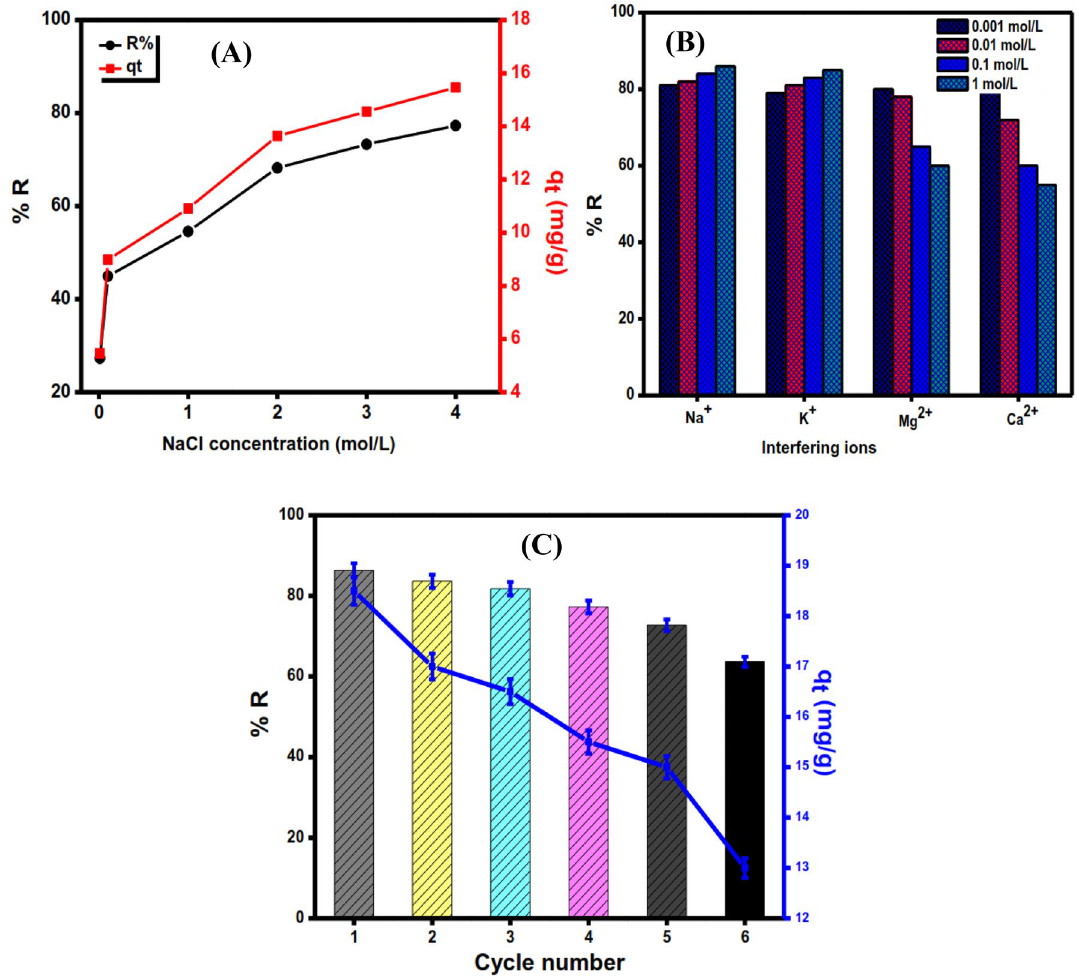
Figure 11. Effect of ionic strength of NaCl ( A ), and interfering ions ( B ) on the adsorption removal of DC onto rGO/nZVI composite [C o = 50 mg L −1 , pH = 7, T = 25 °C, NaCl concentration = 0.01–4 mol L −1 , interfering ions concentration = 0.001–1 mol L −1 , and dose = 0.05 g]. Regeneration and reusability of rGO/nZVI composite in DC adsorption ( C ) [C o = 50 mg L −1 , pH = 7, T = 25 °C, and dose = 0.05